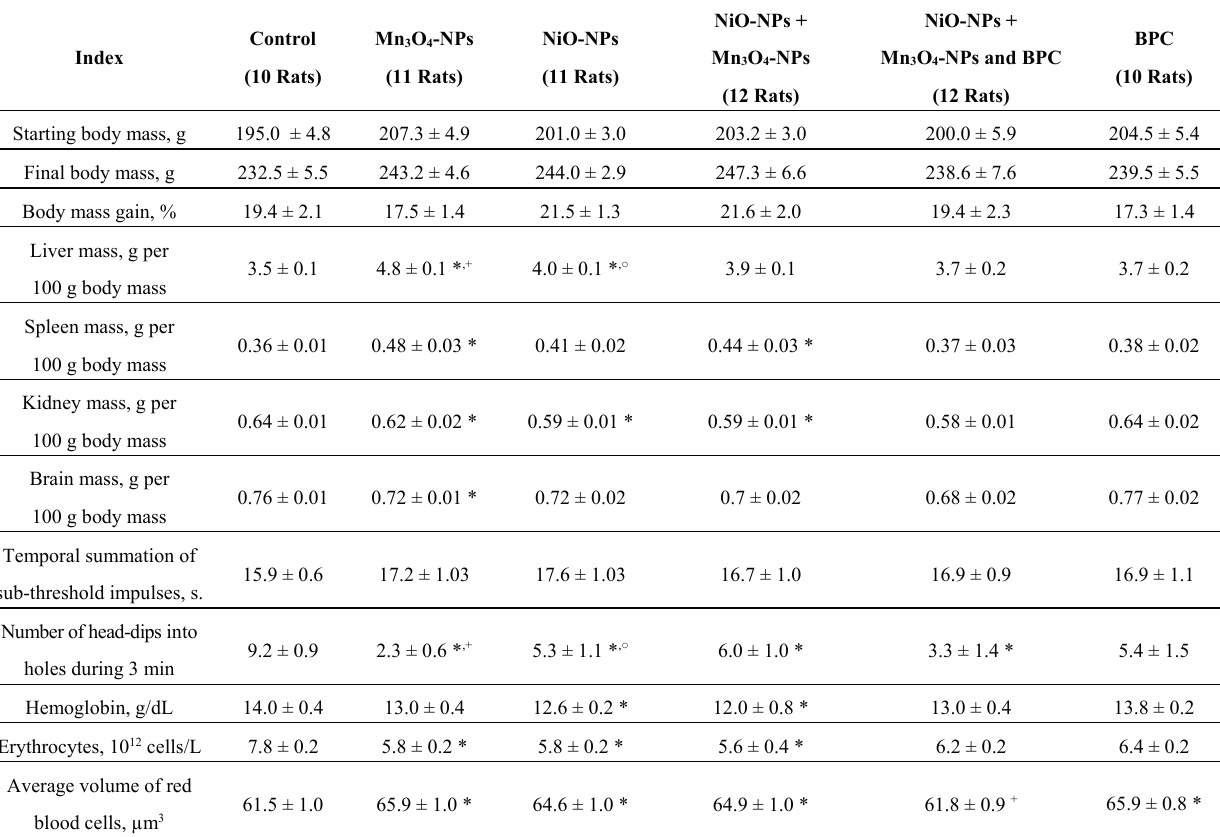
injections of NiO or Mn 3 O 4 nanoparticles separately and of their combination with background oral administration of the BPC (X ±